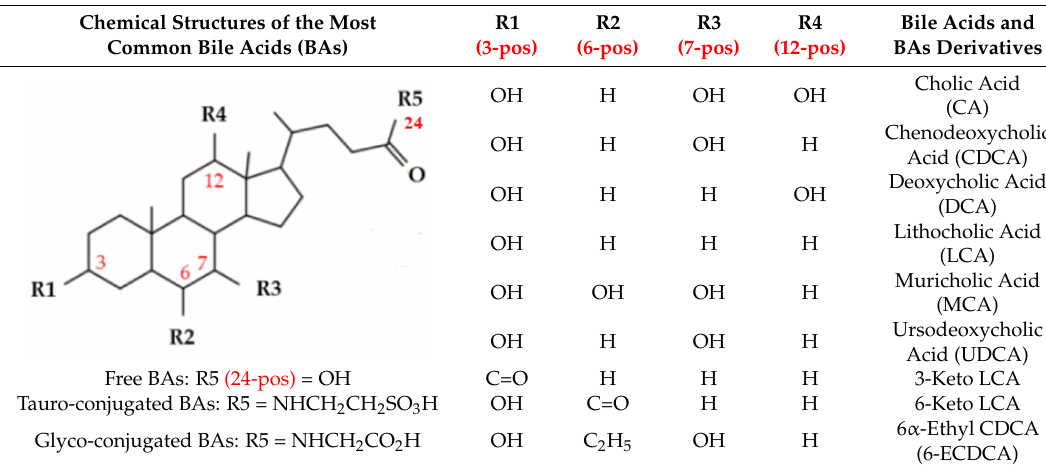
Table 1. Chemical structures of the most common bile acids (BAs) and their conjugated forms (with taurine or glycine). The positions of hydroxyl groups, which are responsible for major physicochemical differences among the BA species, are indicated. Cholic acid (CA) and chenodeoxycholic acid (CDCA) are primary BAs. Deoxycholic acid (DCA) and lithocholic acid (LCA) are secondary BAs. The hydrophobicity increases as follows: MCA, UDCA, CA, CDCA, DCA,